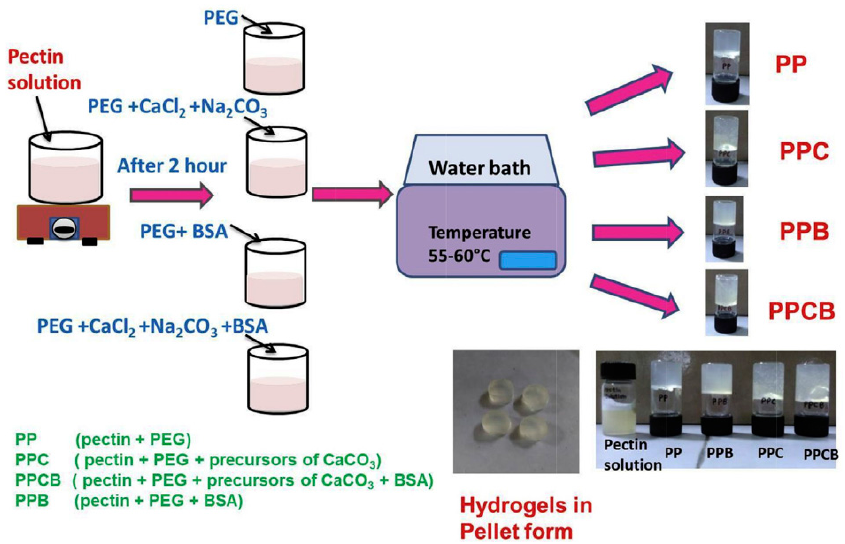
Figure 3. Scheme showing the formation of Pec-g-PEG-MAA hydrogels. Reproduced with permission [53].